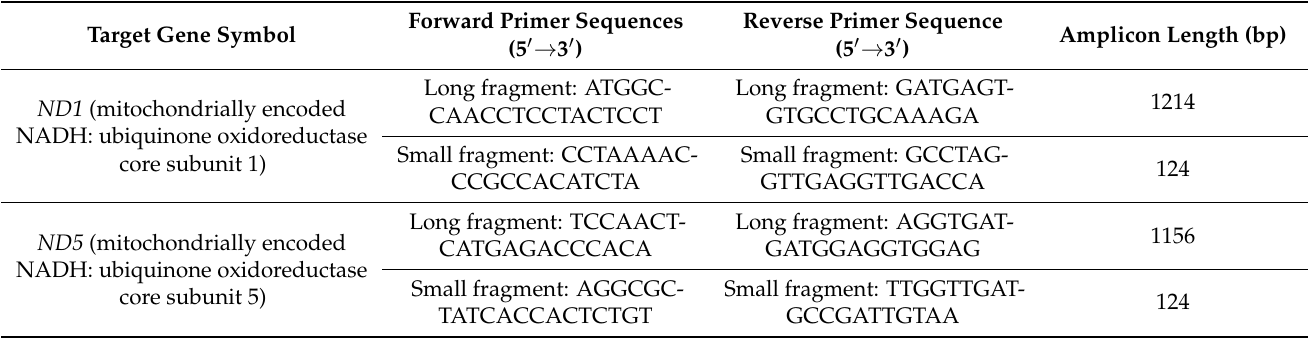
Table 1. Specifications of the SLR-qRT-PCR primers used for the quantification of mitochondrial DNA